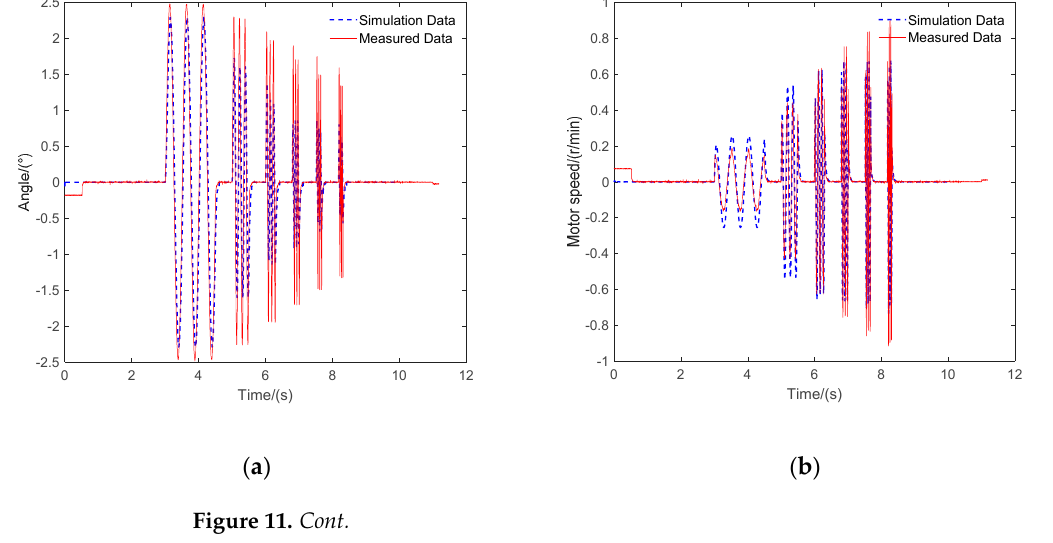
Figure 10. Comparison between simulation data and actual data of each variable of no-load 10-degree step command. ( a ) Angle comparison; ( b ) Motor speed comparison; ( c ) q axis current; ( d ) d axis current; ( e ) Pressure difference between the left and right chambers of the hydraulic cylinder.